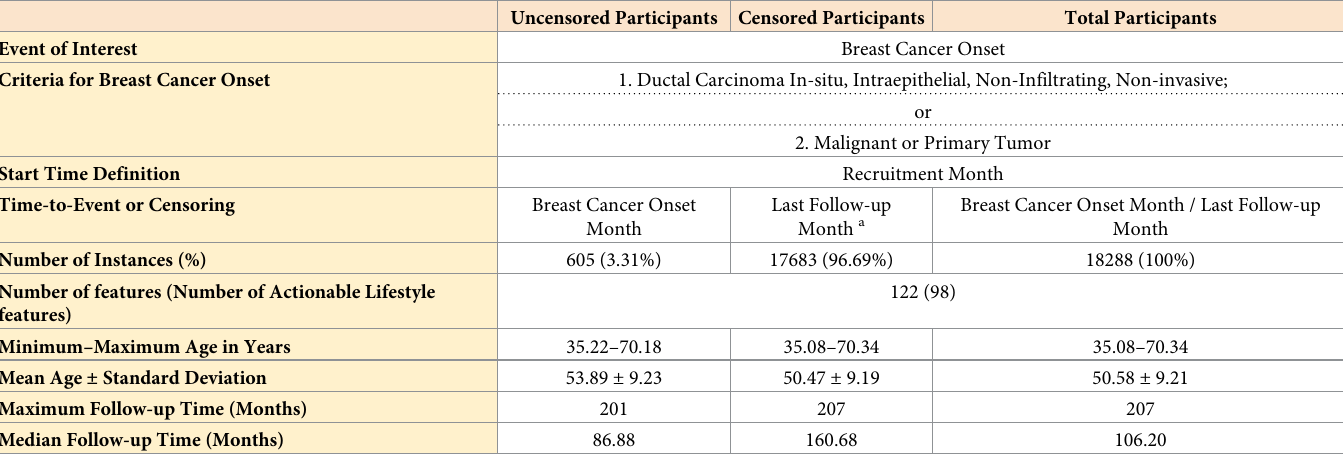
Table 1. The definition and characteristics of female participants in the ATP-BCa dataset.